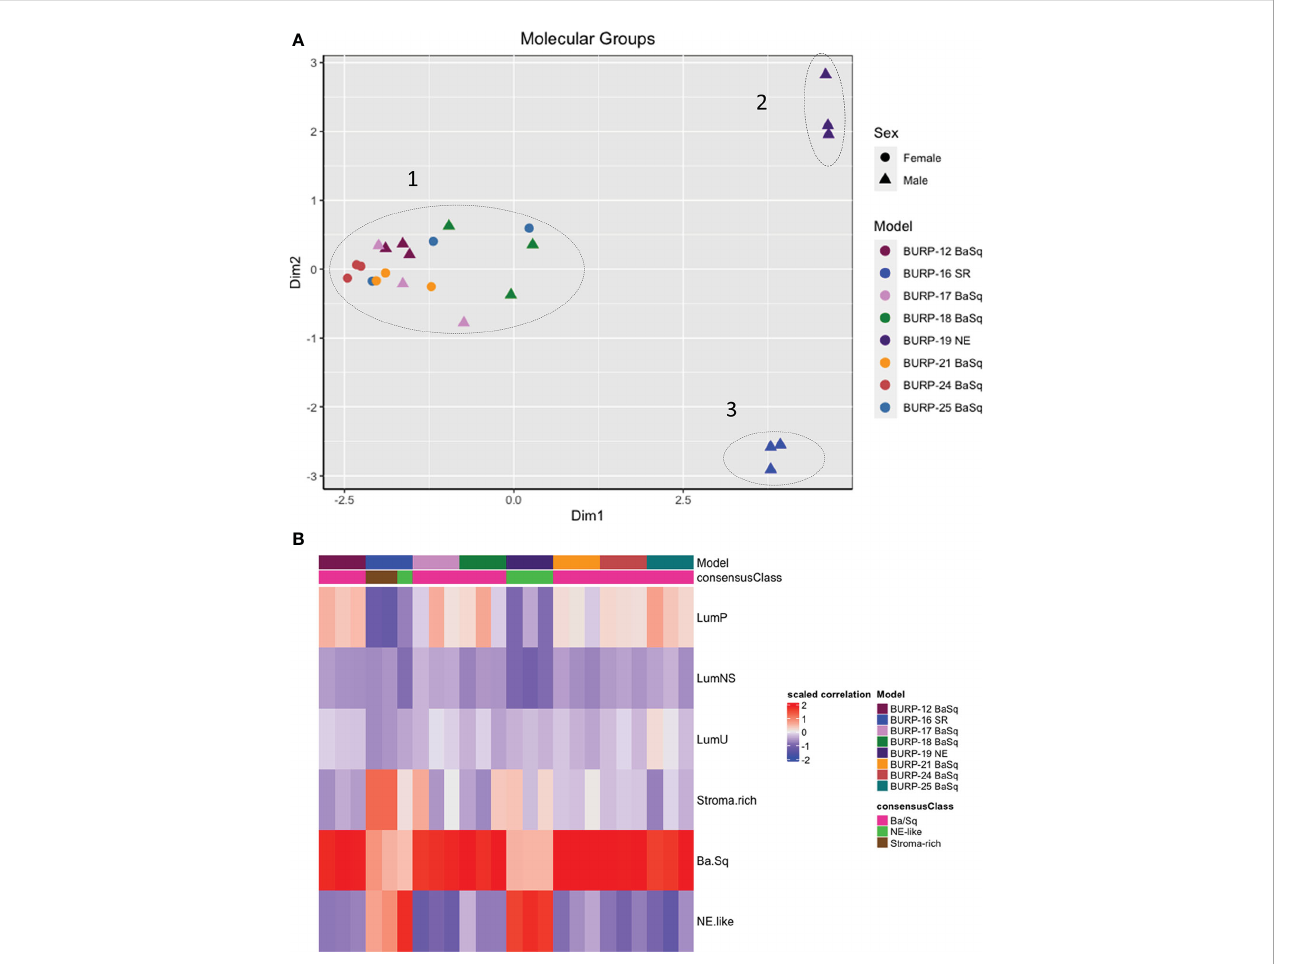
FIGURE 3 Molecular characterization of BURP tumor lines. (A) Multidimensional scaling (MDS) analysis of gene expression in the eight BURP tumor lines. Each data point represents an individual tumor with different colors representing different BURP tumor lines. Male lines are indicated by a triangle and female lines by a circle. The dotted lines mark three different clusters. The x and y axis depict eigenvalues in 2 dimensions (Dim1 and Dim2). (B) Heatmap of Molecular Consensus classi fi ers from Kamoun et al., 2020 for the BURP tumor lines. The color represents scaled correlation coef fi cient values between the BURP tumor line transcriptome data and the Consensus classi fi ers. Red represents higher correlation, and blue represents lower